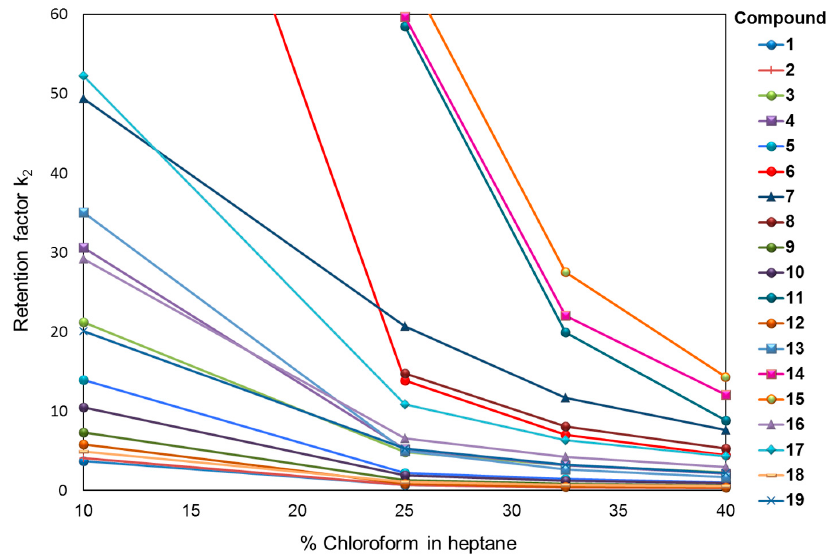
Figure 5. Chromatographic resolution of compounds 1 – 19 on PMBC-Im E with heptane/chloroform as the mobile phase. Retention factor k 2 vs. chloroform content in heptane. Molecules 2016 , 21 , 1740